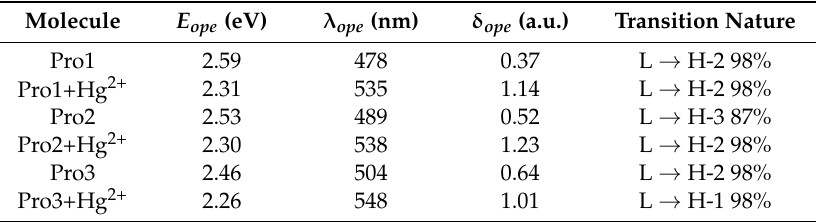
Table 3. Fluorescent emission properties, including the emission energy E ope (eV), the corresponding emission wavelength λ ope (nm), and the oscillator strength δ ope (a.u.) for Pro1, Pro1+Hg 2+ , Pro2,